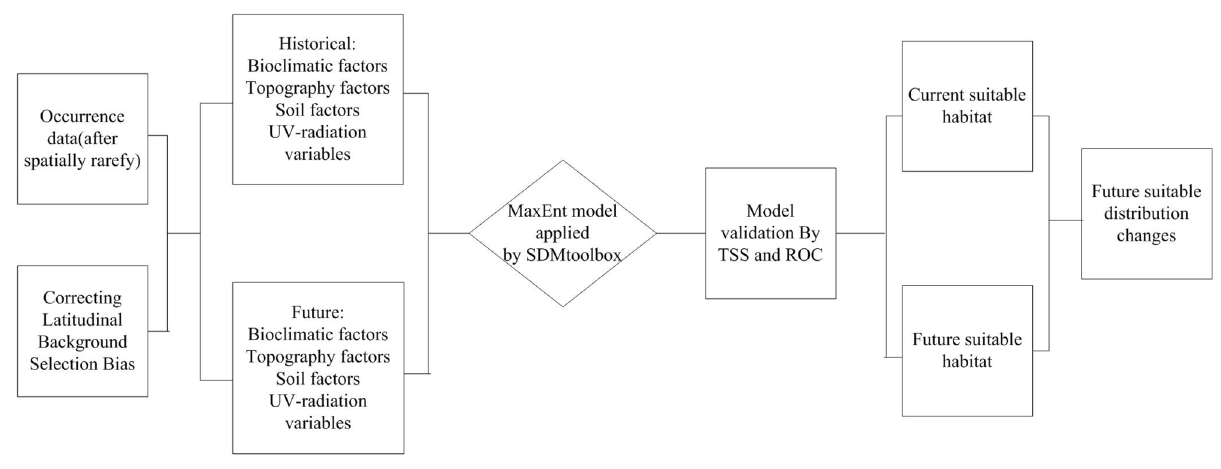
Figure 4. Design framework of the suitable habitat distribution model for Sapindus